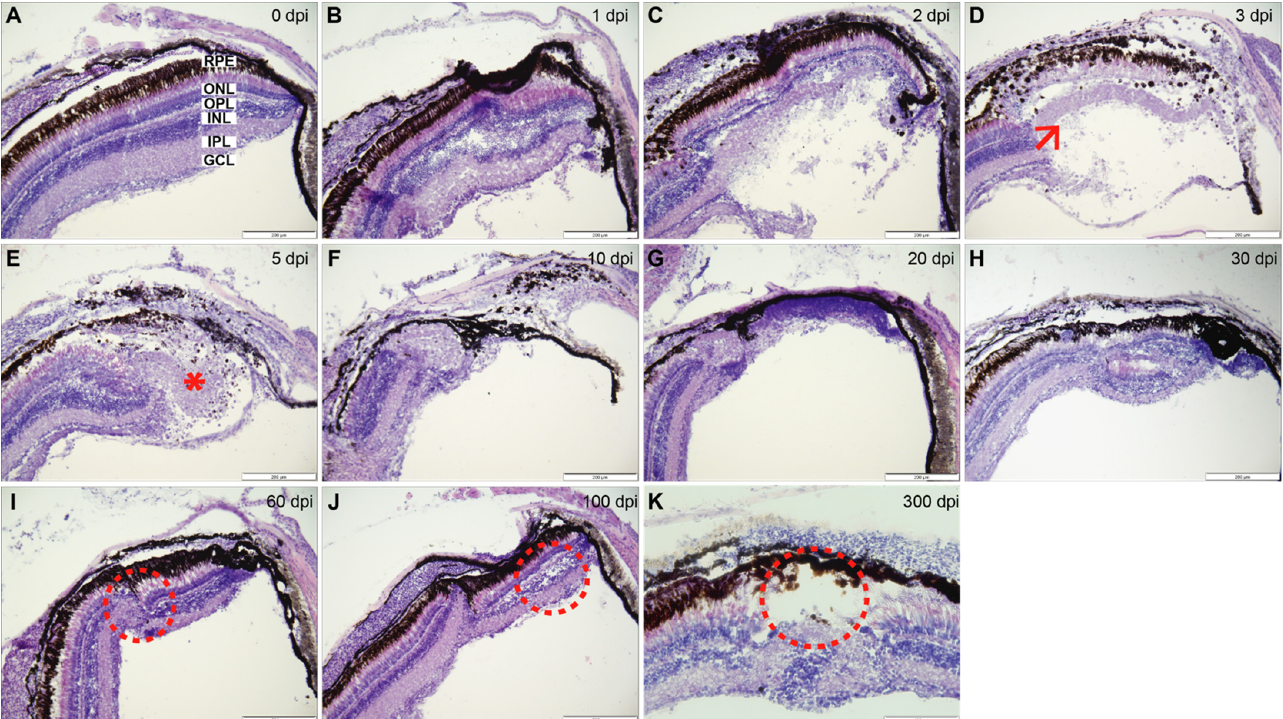
Figure 2. Hematoxylin and eosin staining: ( A ) Control staining in uninjured retina (0 dpi) with distinct retinal layers. ( B ) 1 dpi: edema in the lesion area particularly affecting the IPL and INL. ( C ) 2 dpi: severe edema causing a major disruption to majority of the retinal layers. ( D ) 3 dpi: degeneration phase, coagulative necrosis involving all retinal layers and the formed ‘blister’. Low numbers of polymorphonuclear and mononuclear inflammatory cells were detected (arrow). ( E ) 5 dpi: remodeling phase, ‘blister’ is still present, expansion of and piling of retinal cells at the lesion periphery coincide with maximal proliferation levels (*). ( F ) 10 dpi: lesion size noticeably smaller in comparison to previous time points. ( G ) 20 dpi: lesion size reaches the thinnest point, clearing of dead cells complete. ( H ) 30 dpi: regrowth phase, largely regenerated retina, a clearly dysplastic region is evident exhibiting a mixture of retinal cells and absence of lamination. ( I , J ) 60 and 100 dpi: focal retinal reorganization, reduced number of rods and cones, inward growth of RPE, focal disruption and convergence of INL and ONL (circled). ( K ) 300 dpi: incomplete regeneration presenting the absence of photoreceptor outer segments (circled), dysplasia apparent with largely normal retina surrounding the affected area. Retinal layers labelled in control panel for reference; RPE—retinal pigment epithelium, ONL—outer nuclear layer, OPL—outer plexiform layer, INL—inner nuclear layer, IPL—inner plexiform layer, GCL—ganglion cell layer. 300 dpi at 40× with scale bar representing 100 µm to show the full regeneration process. Rest of scale bars represent 200 µm.